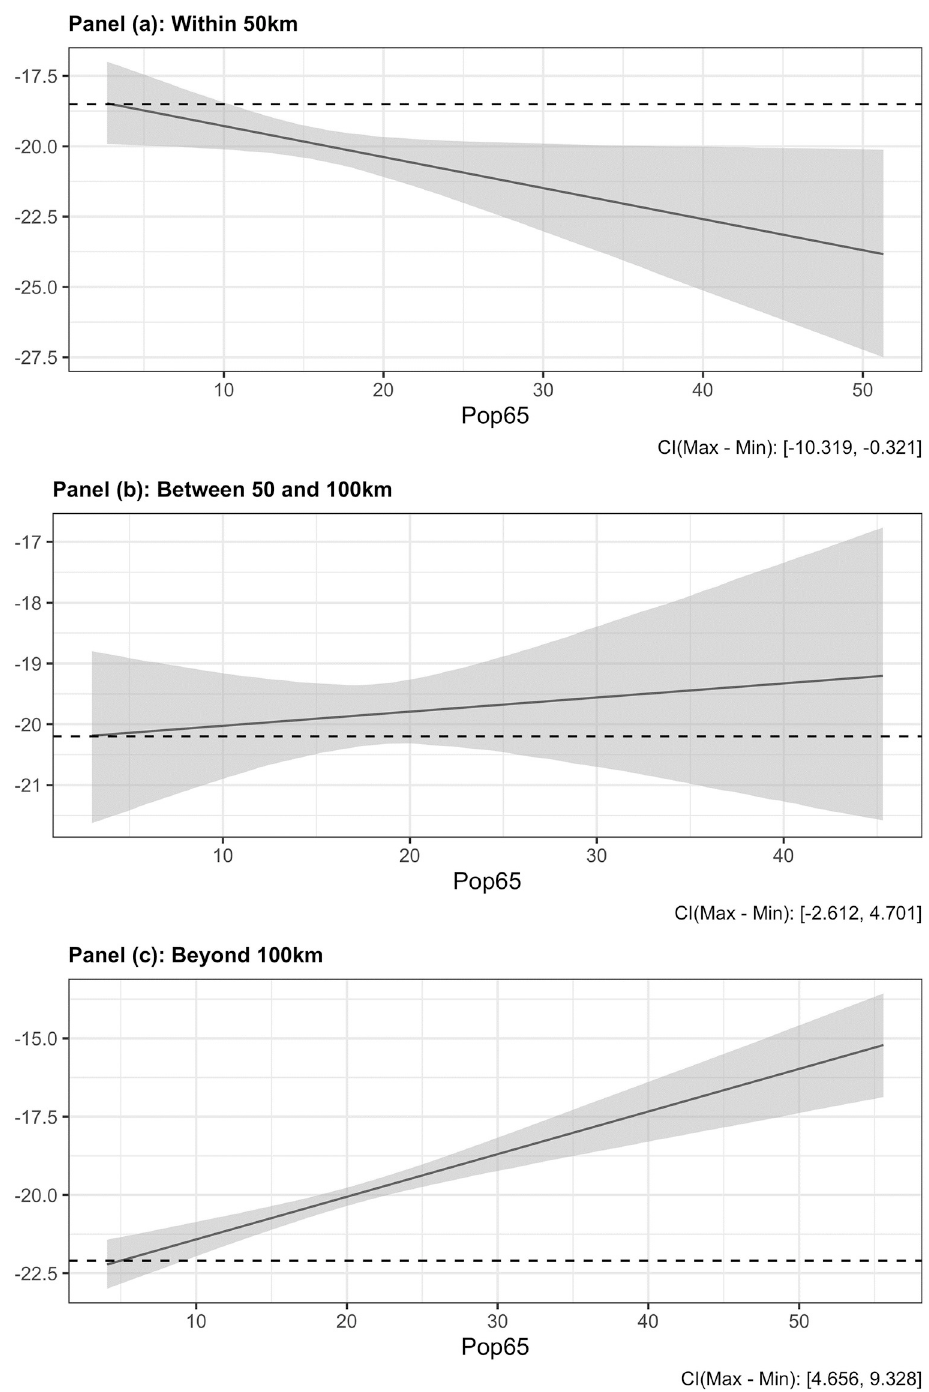
Fig 4. Impact of the share of old voters on turnout (breakdown by distance to nearest COVID-19 clusters). The vertical axis shows the percentage change (decrease) between 2014 and 2020. The models include Unique list and Number of registered voters as control